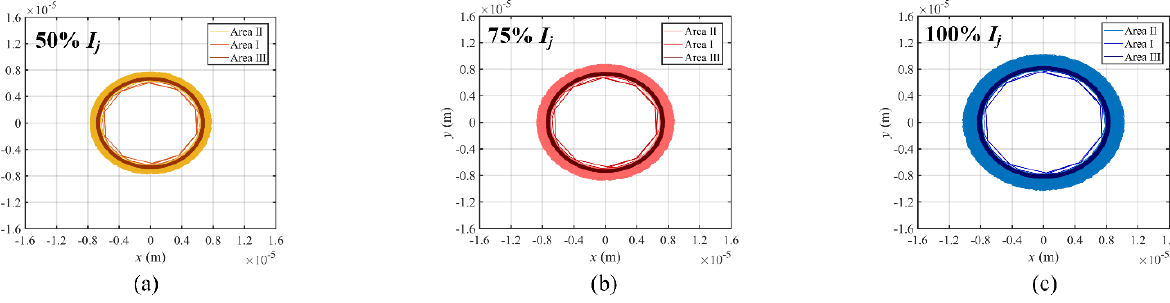
Figure 20. The time-domain figure of the generator rotor under different average air gaps between the stator and rotor. ( a ) In x -direction; ( b ) in y -direction.